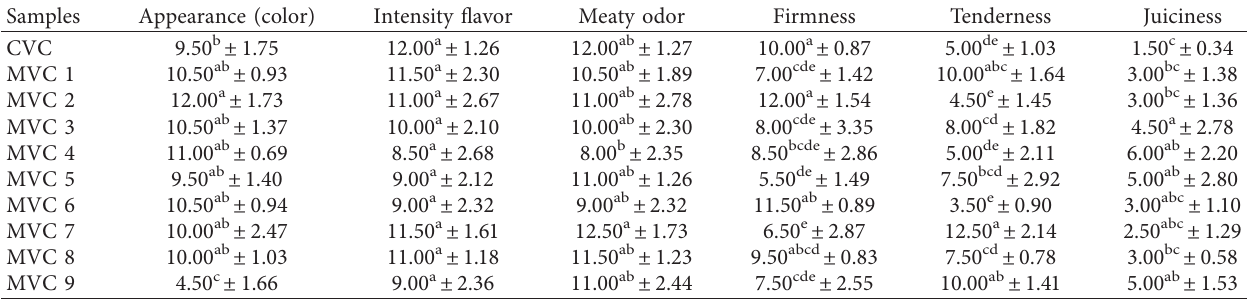
Table 13: Comparative attributes between control village chickens (CVC) and market village chickens (MVC) sold at a different market. Samples